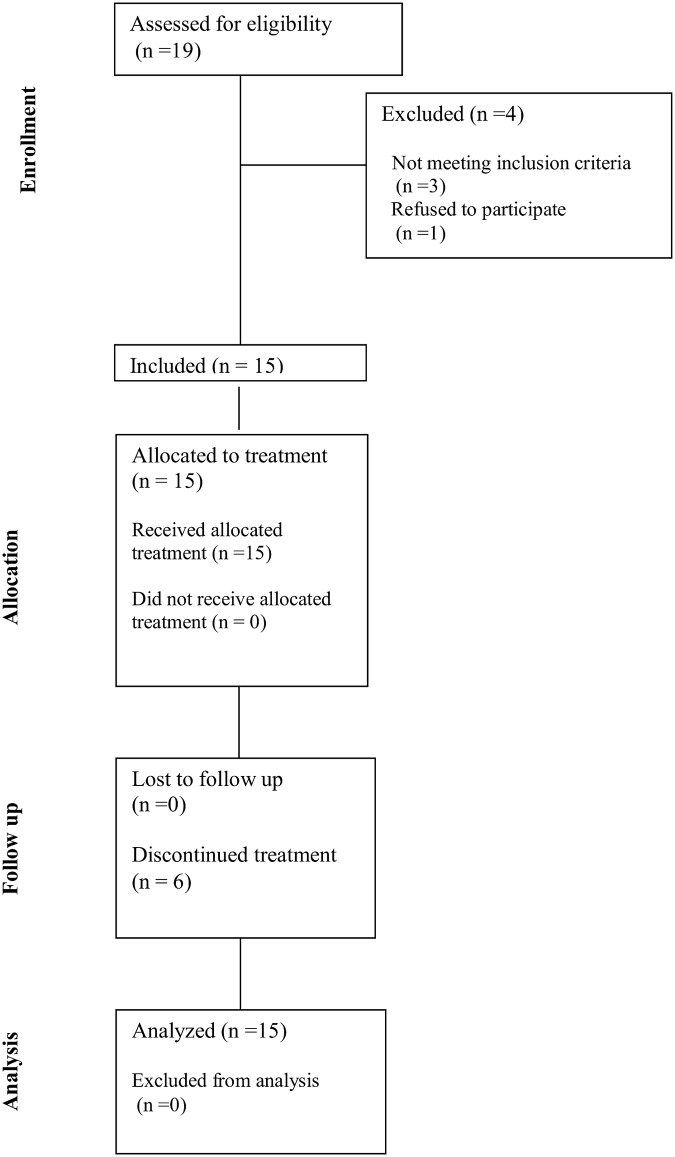
CONSORT Diagram.